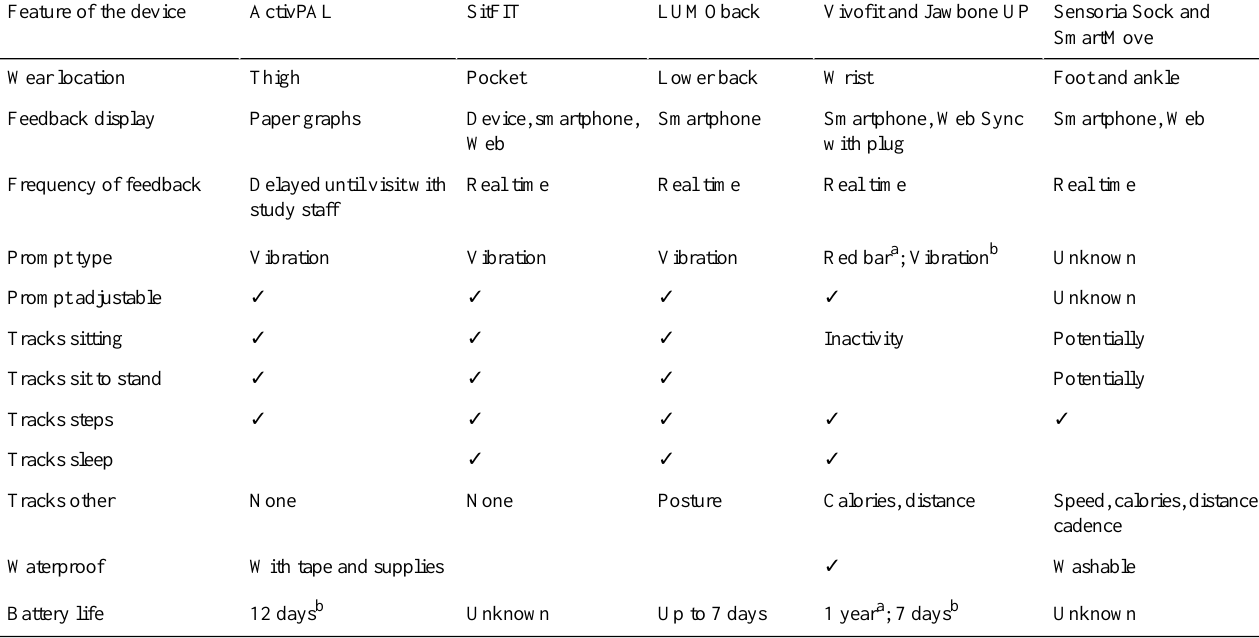
Table 1. Description of the seven wearable devices reviewed during the focus groups. We organized the devices based on wear